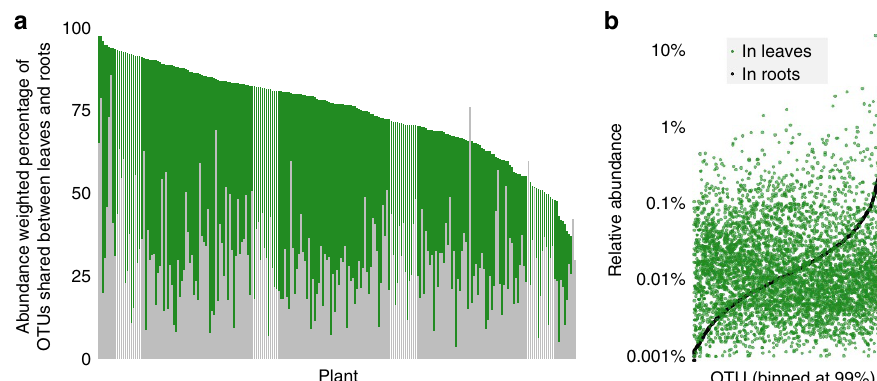
Figure 8 | A large fraction of leaf OTUs were also observed within roots of the same plant. ( a ) Each bar shows the total fraction of leaf (green) and root (grey) OTUs (binned at 99% sequence similarity) belonging to the ‘shared set’ of OTUs that were observed in both organs within one plant ( N ¼ 237 plants). ( b ) Root OTUs from across the relative abundance spectrum contributed to the bacterial leaf microbiome. All root OTUs are plotted in increasing order of their relative abundance in roots (black dots). For each OTU that was also observed in leaves, its relative abundance in the leaf microbiome is plotted above or below it (green